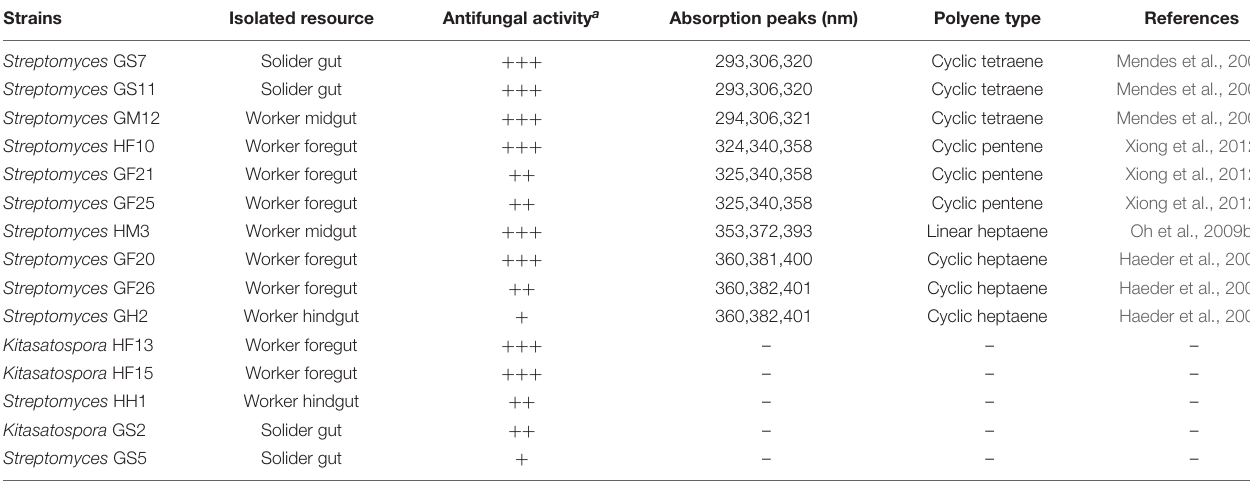
TABLE 1 | Predicted polyenes from antifungal crude extracts of isolated actinomycetes.